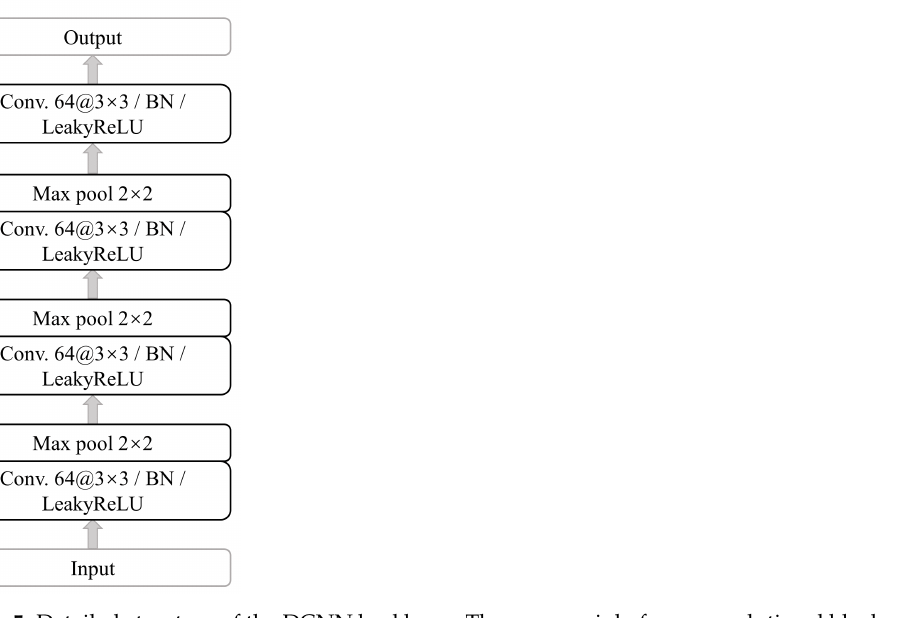
Figure 5. Detailed structure of the DCNN backbone. There are mainly four convolutional